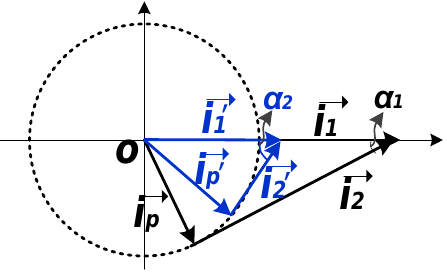
Figure 7. The vector interpretation of current changing.